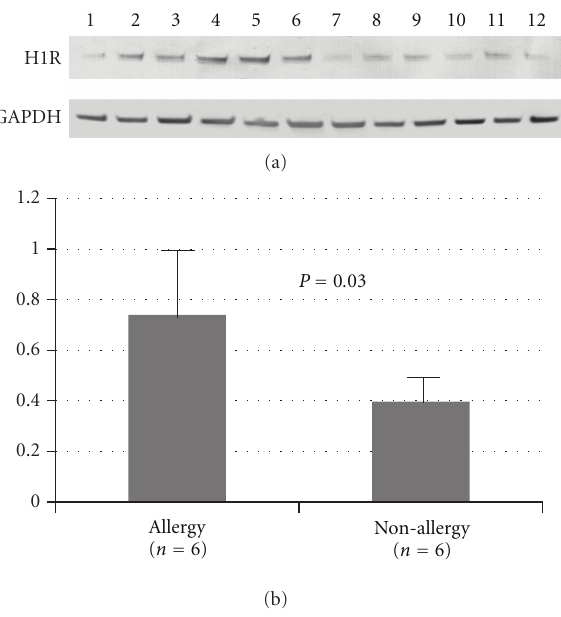
Figure 3: Western blots showing H1 receptor protein level in allergic nasal mucosa (lane 1–6) and nonallergic nasal mucosa (lane 7–12). Densitometric analysis of the relative protein level of H1 receptor as shown in (b). The data were expressed as mean ± SD and normalized to